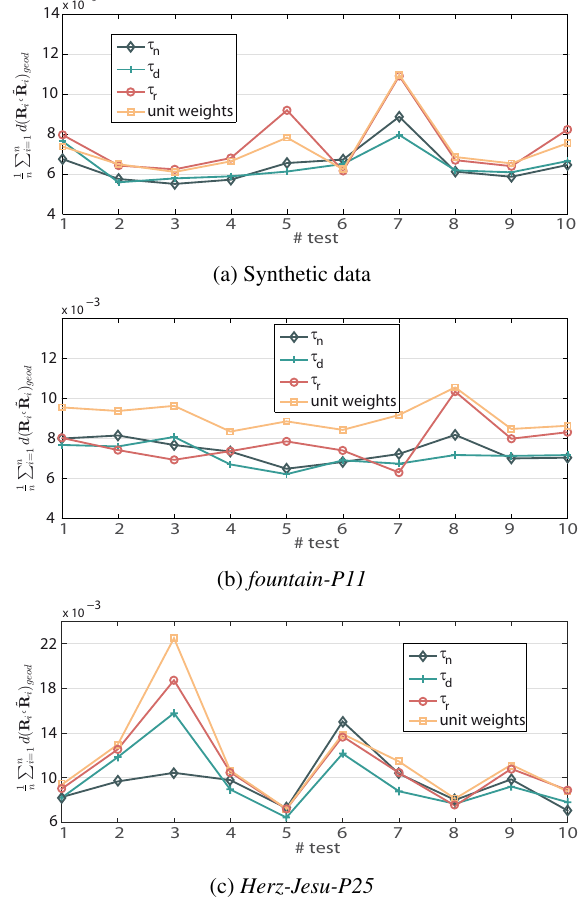
Figure 6: Estimation results depicted as the average distance to the respective ground truth information ˜R in [ rad ] using different indicators responsible for weighting relative rotations and unit weights as